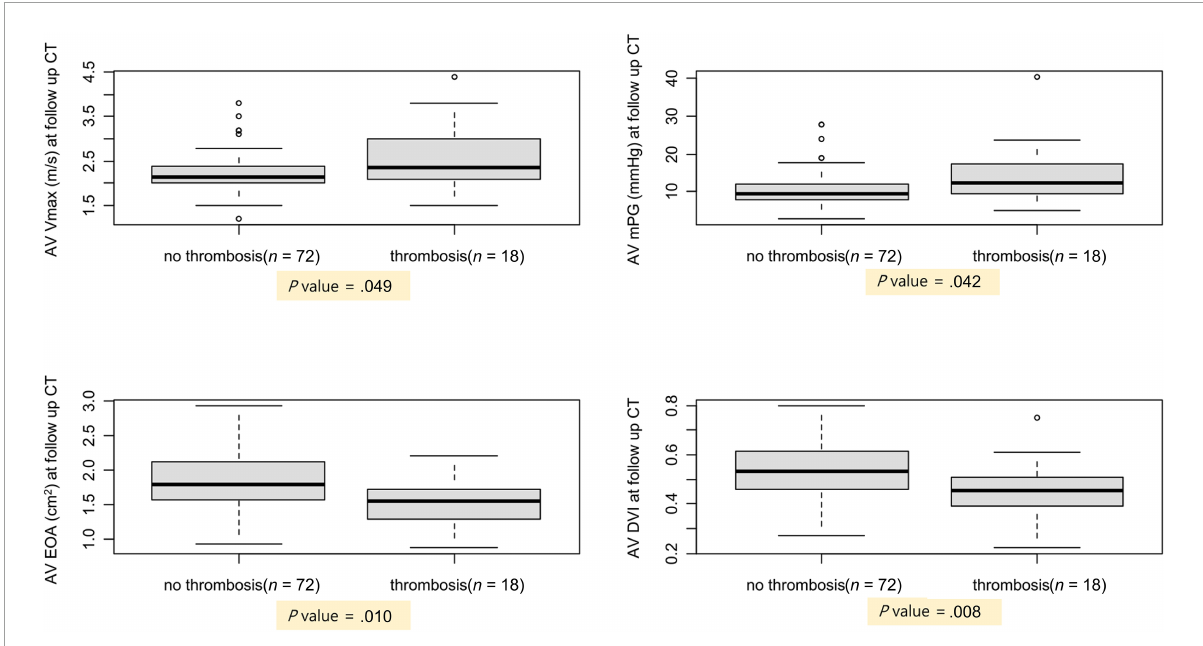
FIGURE3 Comparison of AV hemodynamics between patients with and without subclinical leaflet thrombosis. AV, aortic valve; CT, computed tomography; DVI, Doppler velocity index; EOA, estimated orifice area; mPG, mean pressure gradient; Vmax, peak aortic valve velocity.